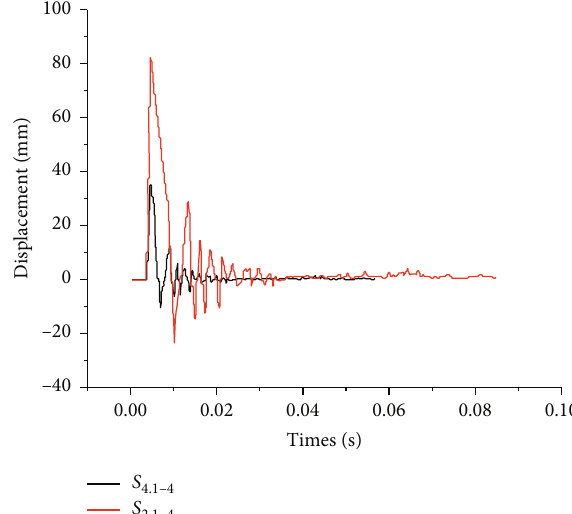
Figure 20: Column top displacement chart of impact forces at different impact heights of